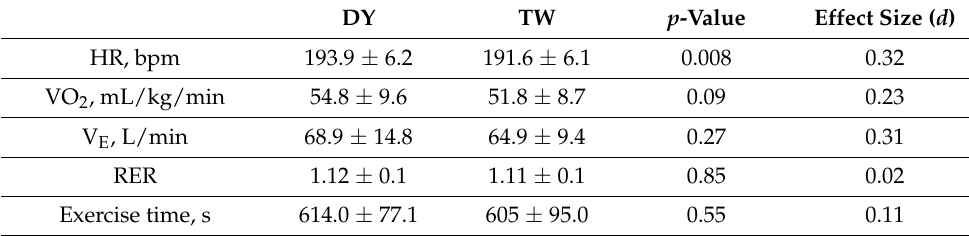
Table 2. Peak cardiometabolic responses during maximal aerobic capacity exercise testing following a dynamic warm-up (DY) and a treadmill walking warm-up (TW). DY TW p -Value Effect Size ( d ) HR,